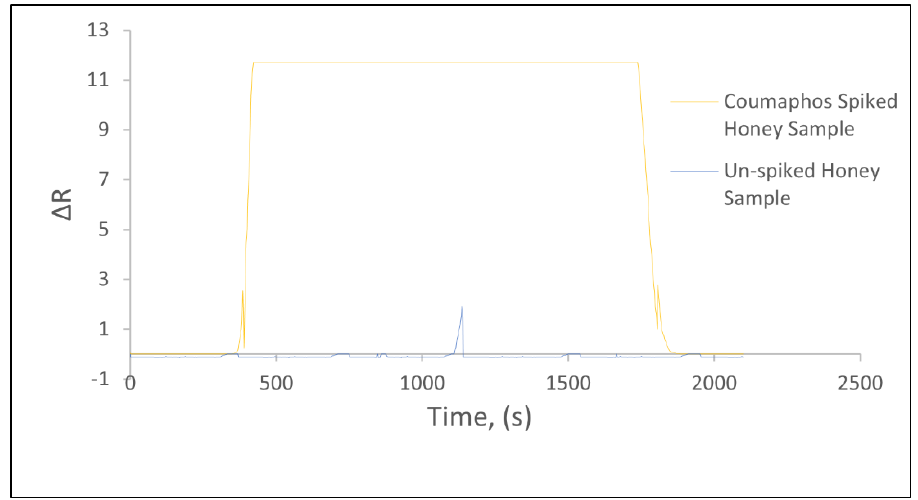
Figure 9. CIP SPR sensor response for Coumaphos spiked (100 ppb) and unspiked honey